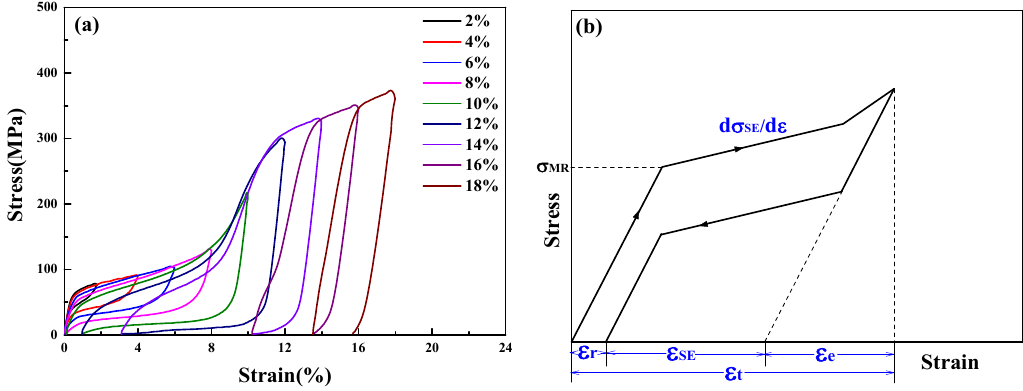
Figure 5. ( a ) SE cyclic stress-strain curves of a columnar-grained Cu 71.7 Al 18.1 Mn 10.2 alloy sample tested at room temperature; ( b ) sketch map of property parameters based on SE cyclic stress–strain curves.